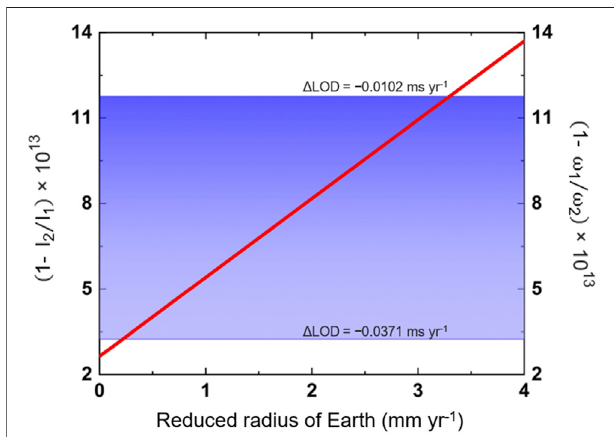
FIGURE 5 | Changes in the moment of inertia of Earth as a function of reducedradiusofthecrust.Redline:changeofthemomentofinertiaofEarth; blue shading: range ofvariation ofthe Earth ’ s angular velocity. Changes ofthe moment of inertia and angular velocity are extremely small, and thus, they are expressed as the vertical axis title. The subscripts 1 and 2 represent thestatesbeforeandaftertheradiusoftheEarthhasdecreased,respectively.